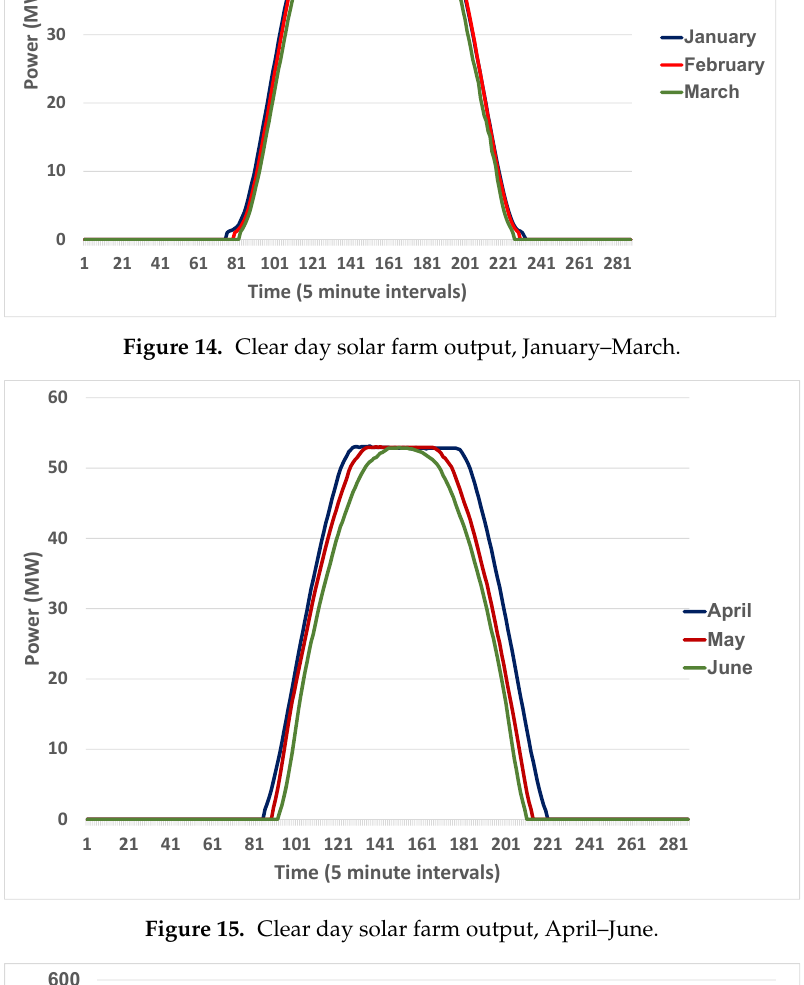
Figure 15. Clear day solar farm output, April–June.